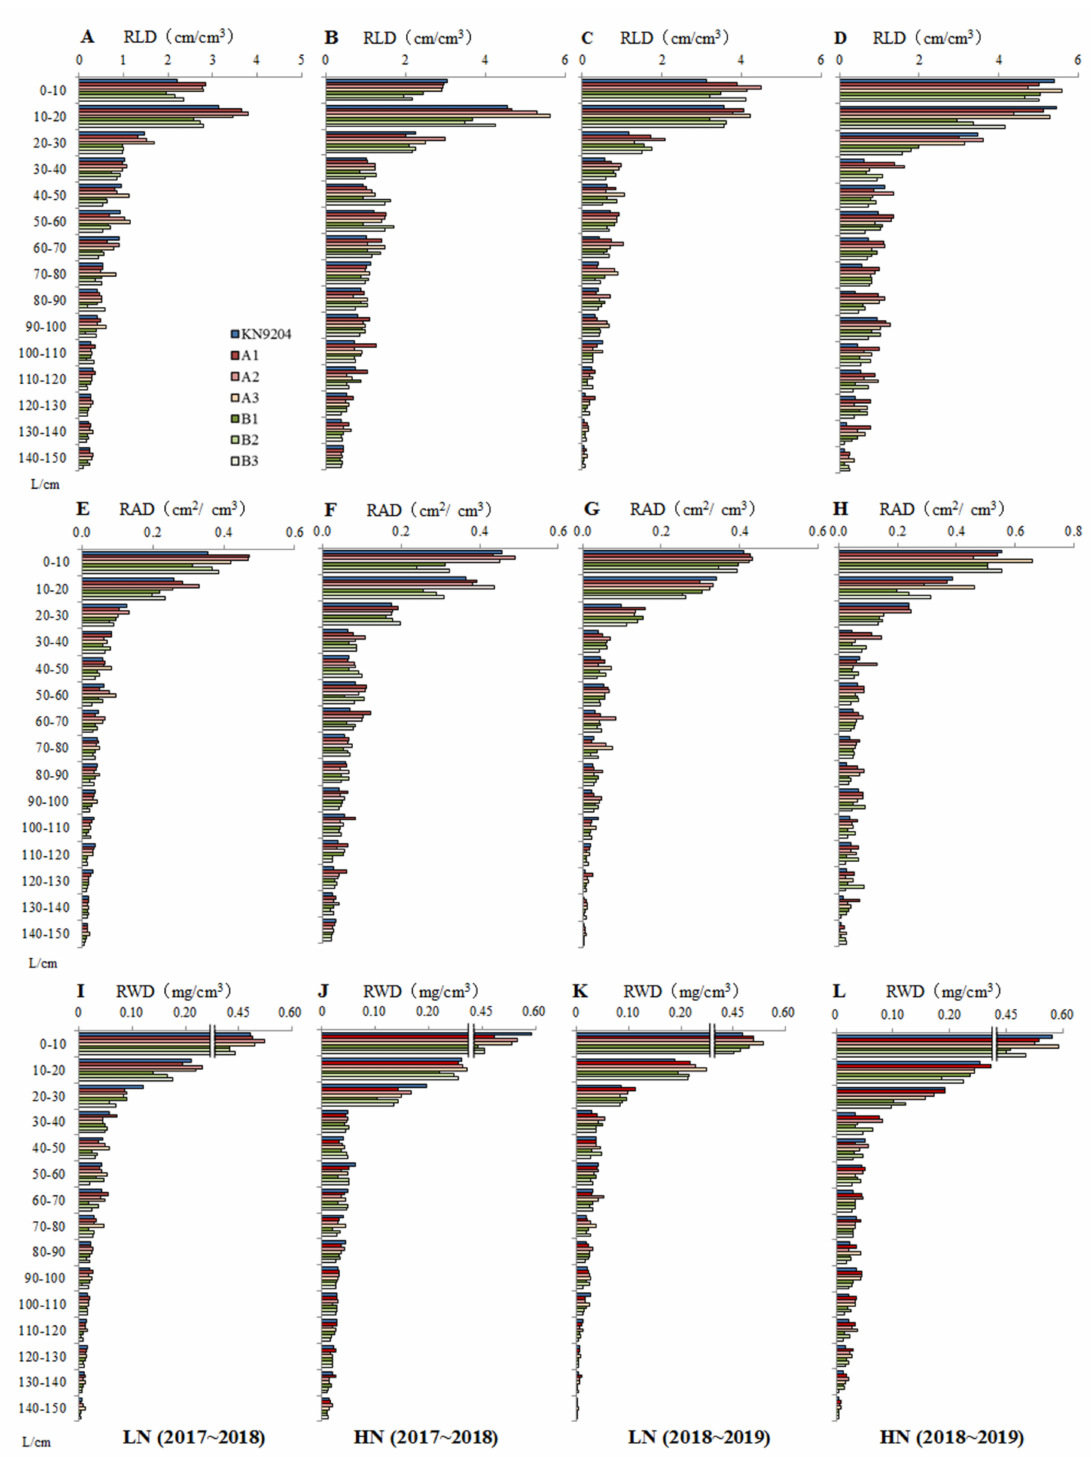
Figure 2. Root length density (RLD) ( A – D ), root area density (RAD) ( E – H ) and root weight density (RWD) ( I – L ) of KN9204 and the QMrl - 7B near isogenic lines (NILs) in different soil layers at 10 days post anthesis. 2017~2018 and 2018~2019 indicate growing seasons; LN and HN indicate low nitrogen and high nitrogen environments, respectively; L indicates soil